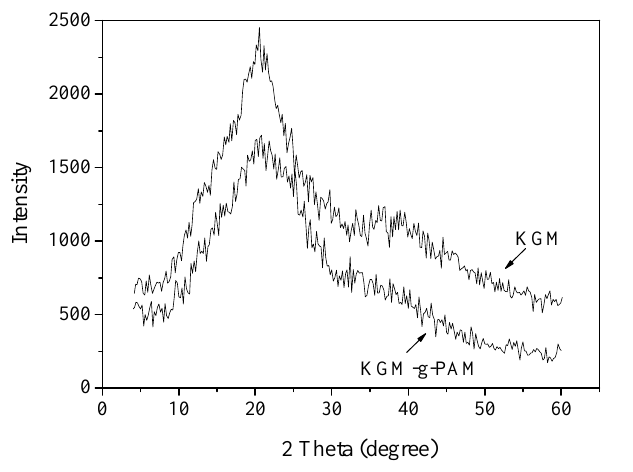
Figure 6. XRD patterns of KGM and